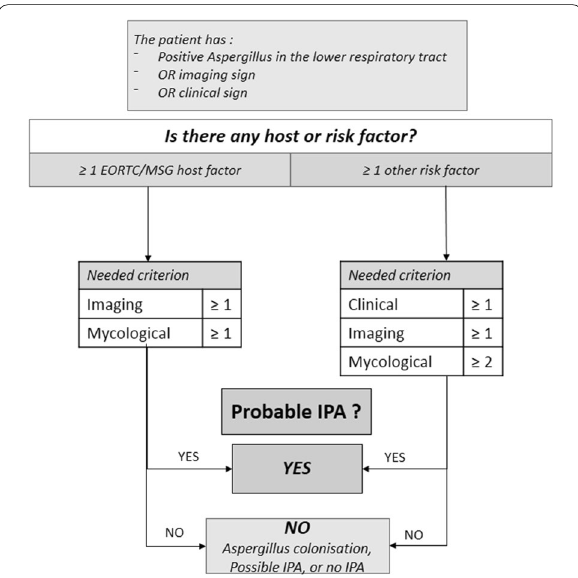
Fig. 1 BM‑AspICU algorithm to discriminate probable invasive pulmonary aspergillosis